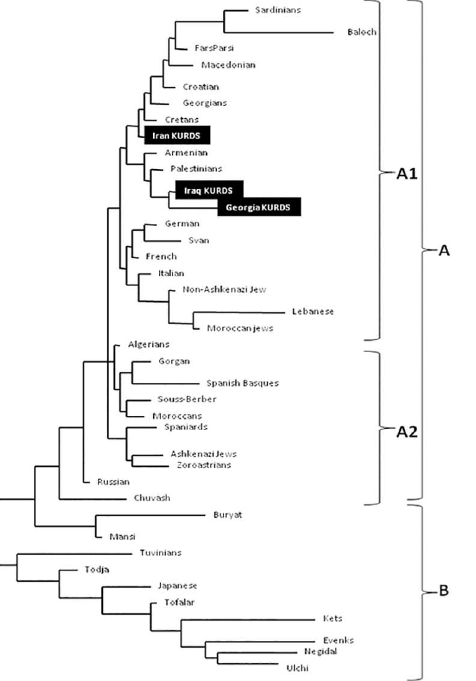
Fig 2. Neighbour-Joining dendrogram. Neighbour-Joining(NJ) dendrogram constructed with HLA-DRB1 allelefrequencies showingrelatedness betweenIraq Kurds and other World populations. Bootstrap values are 100%.